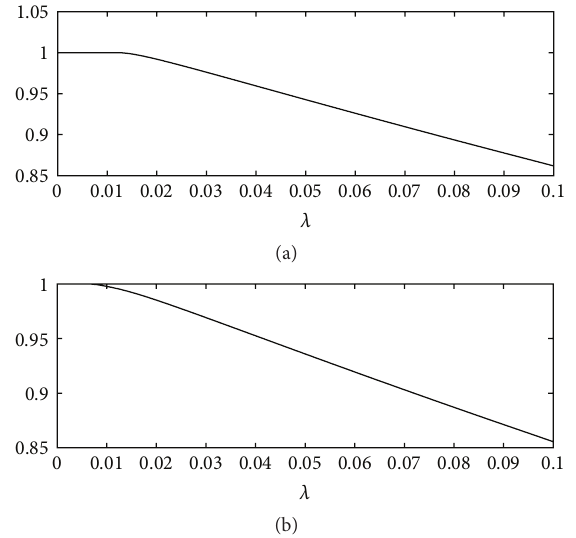
Figure 5: Loan value as a function of the intensity. (a) Regime 𝑋 = 𝑒 𝑋 = 𝑒 1 ; (b) regime 2 . The loan value is decreasing when there is a degradation of the credit quality (i.e., when 𝜆 increases) and converges to 0.